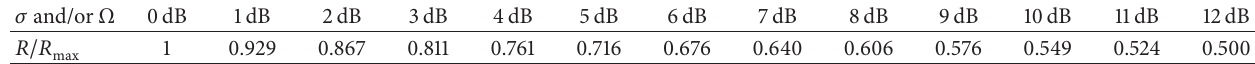
Table 2: Normalized average sensing radius for different shadowing and multipath environments.